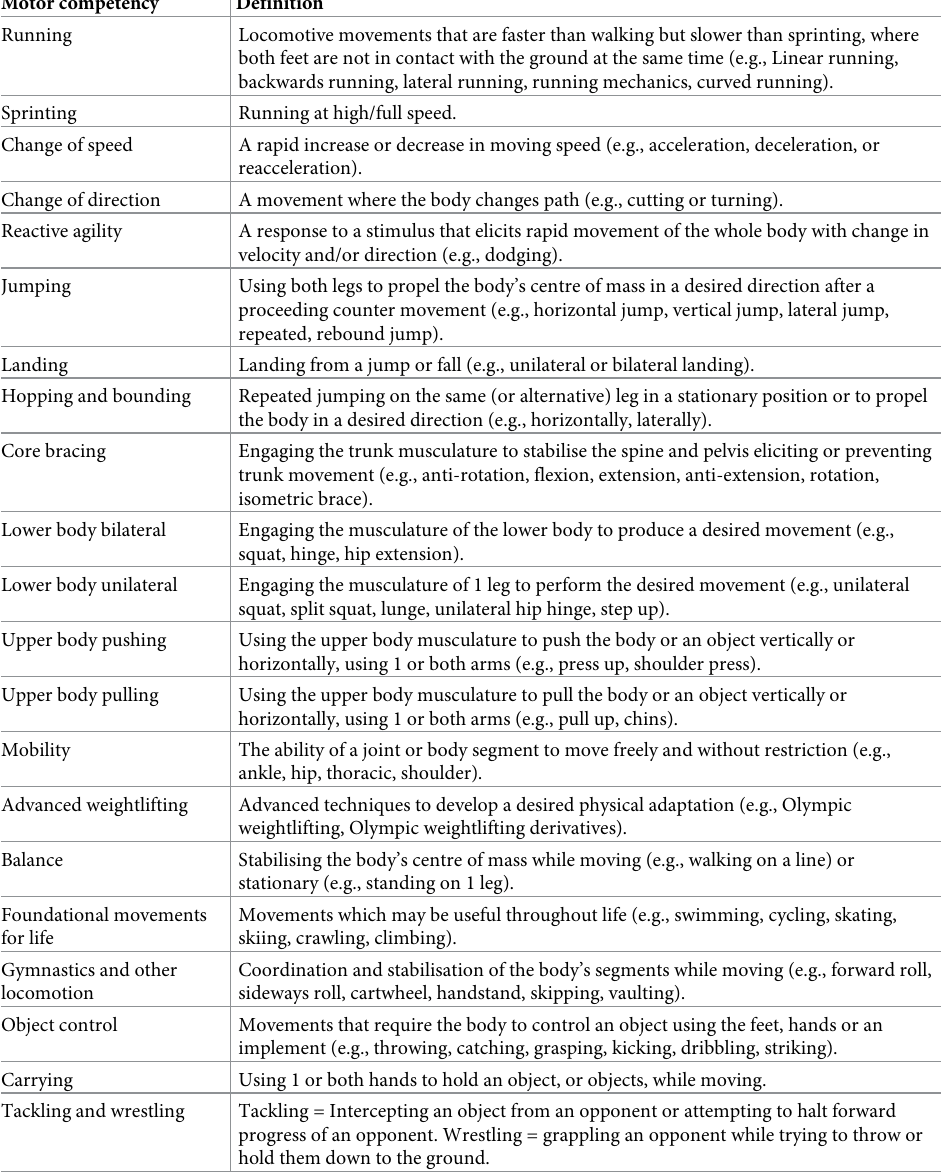
Table 1. List of motor competencies and definitions provided to PE teachers and S&C coaches within the